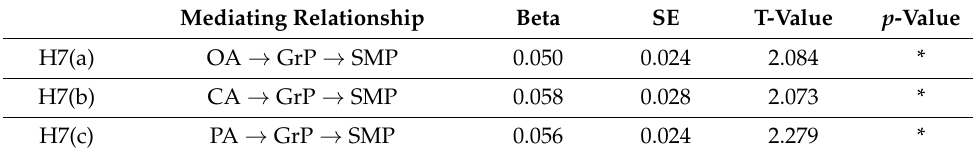
Table 5. Mediation Effect Analysis. * p < 0.05.